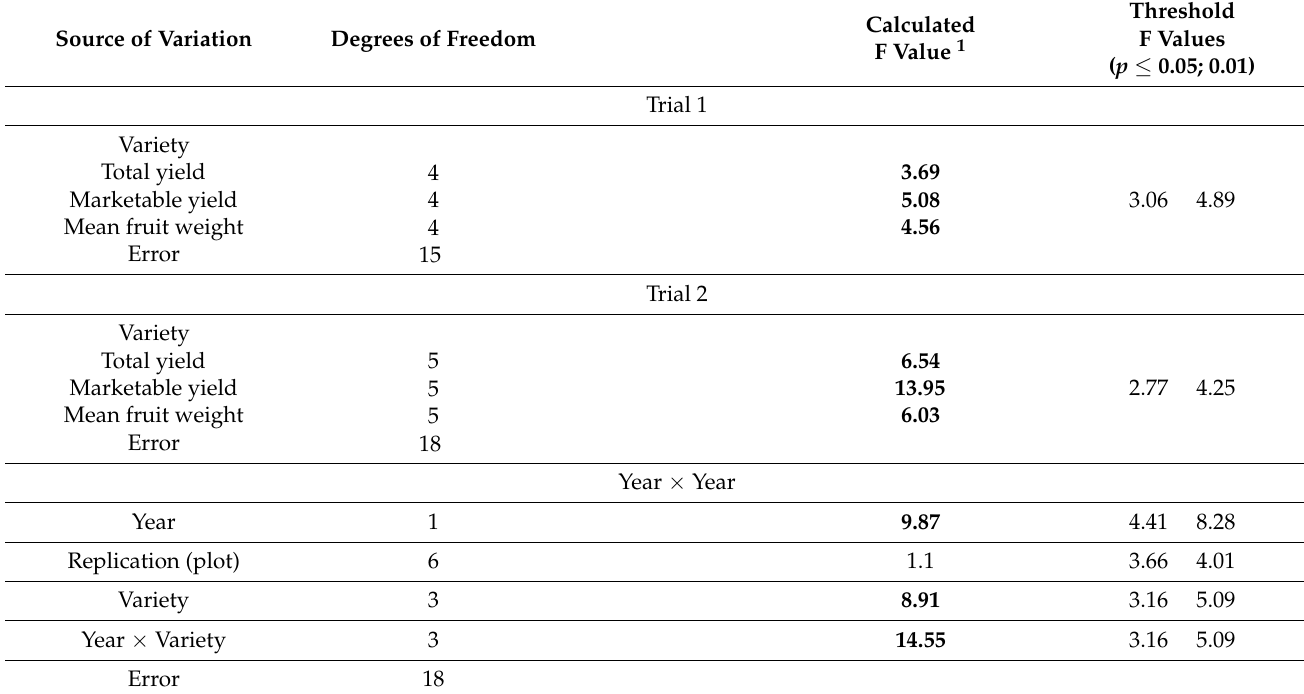
Table 3. Values from an analysis of variance (ANOVA) on total yield per plant, marketable yield per plant and mean fruit weight for two short-day strawberry trials comparing five and six varieties in Trial 1 and Trial 2 in consecutive years in a completely randomized design with four replicates per variety. An ANOVA was performed separately for each parameter. The ANOVA for year by year interactions was performed on mean total yield per plant from the four varieties in common between the two trials (Clancy, Jewel, Ovation and